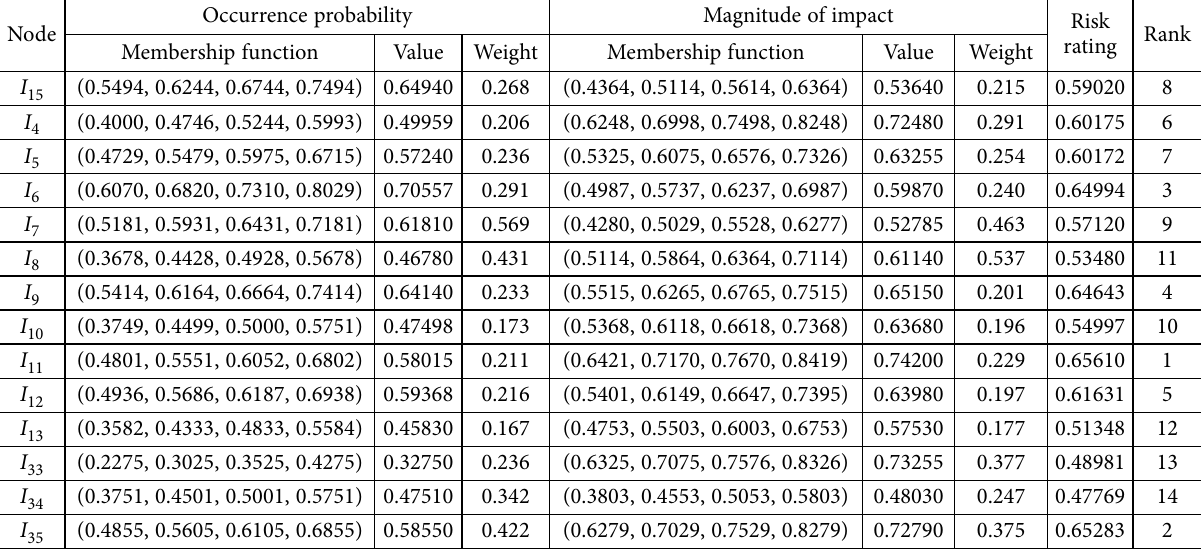
Table 7. RA results of risk groups in the second level for the Ankara-Istanbul high-speed railway project Node